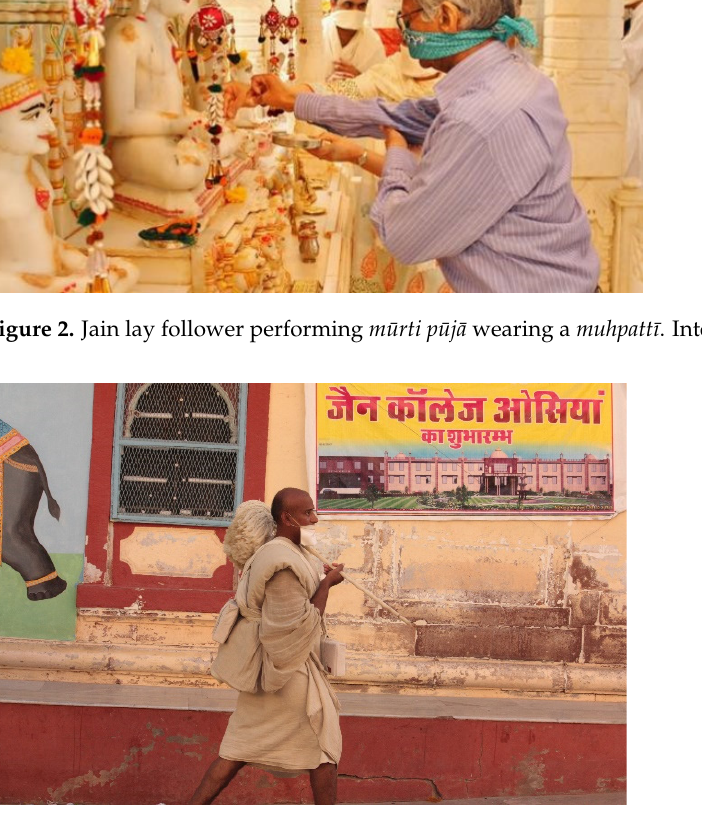
Figure 3. Sth ā nakav ā s ī monk with a muhpatt ī . Jodhpur, December 2015. Photo by the author. Figure 3. Sth¯anakav¯as¯ı monk with a muhpatt¯ı . Jodhpur, December 2015. Photo by the